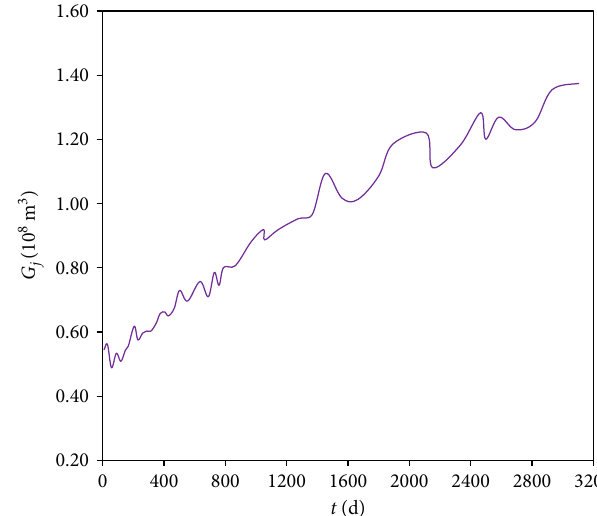
Figure 32: The estimated pro fi le of G